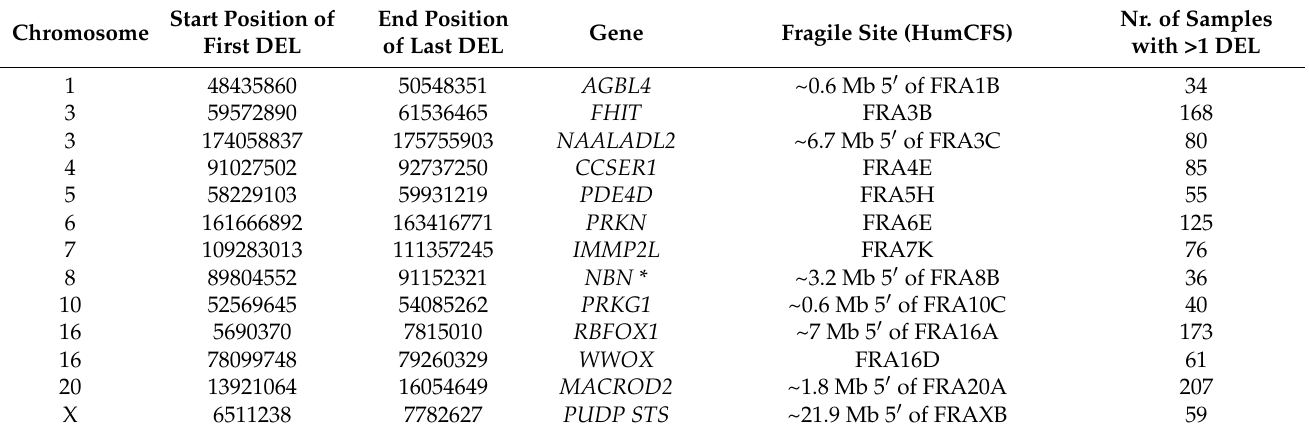
Figure 1. Deletions in mCRC show spatial and size preference. Density plots of structural variant in mCRC ( a ) and of deletions in 3 different metastatic cancers ( b ); ( c ) shows density plots by the indicated sizes across the genome. Figure 1a reproduced from Mendelaar et al., Nat Commun 2021, 12:574 (CC BY 4.0, https://creativecommons.org/licenses/by/4.0/, accessed on 1 December 2021) with modified colors. Table 1. Regions with at least 150 DELs in mCRC.